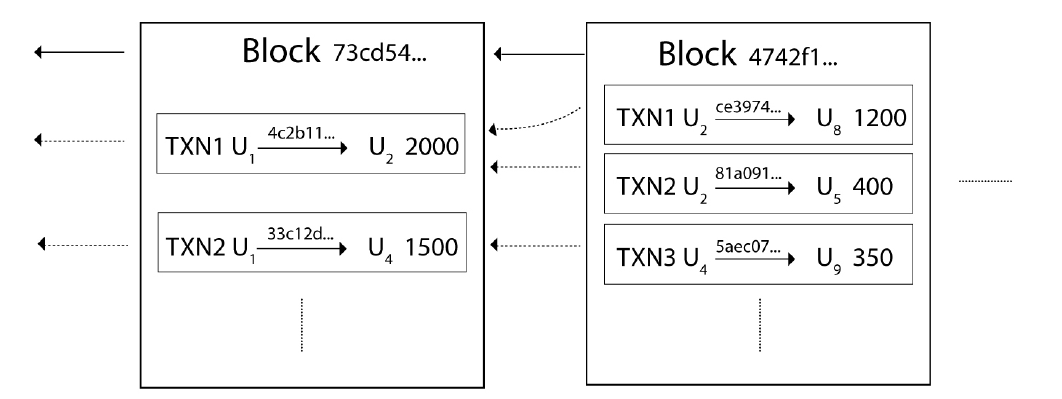
Figure 3. Typical part of the blockchain of our